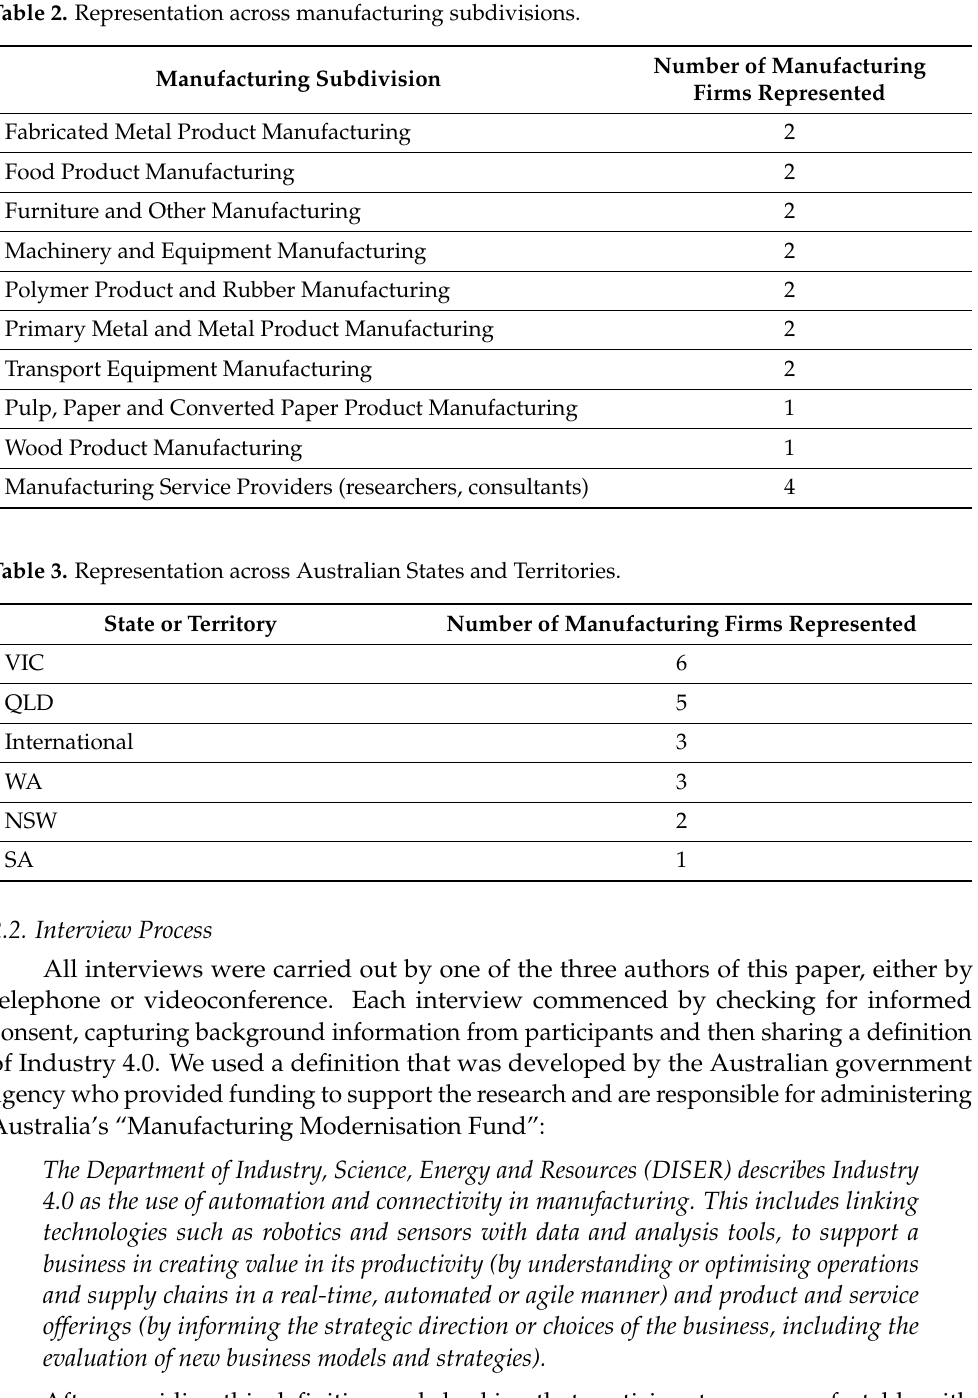
Table 2. Representation across manufacturing subdivisions. Manufacturing Subdivision Fabricated Metal Product Manufacturing 2